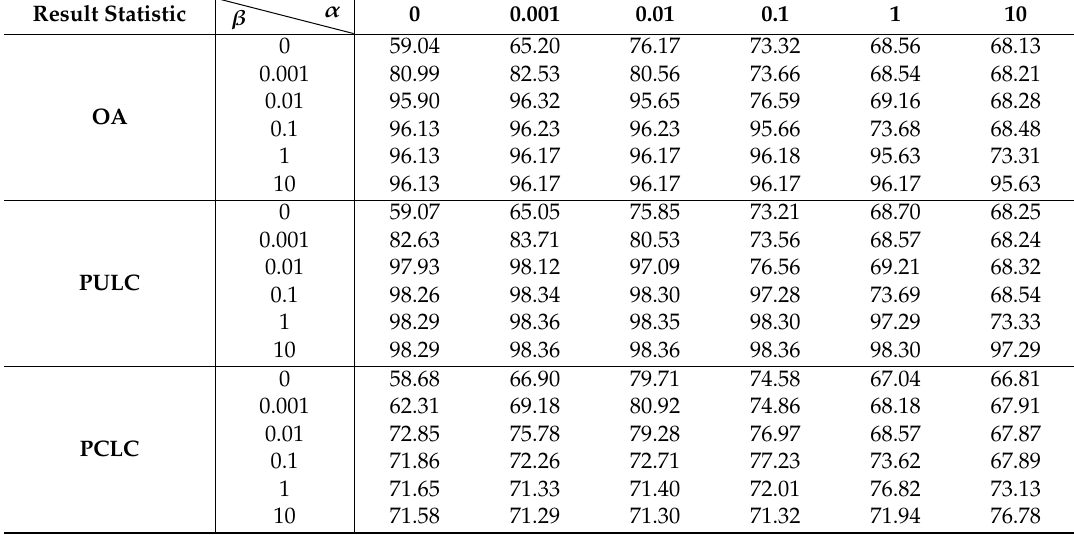
Table 4. Accuracy statistics of the FCM_STSRM method with different weighting coefficients (%). Result Statistic